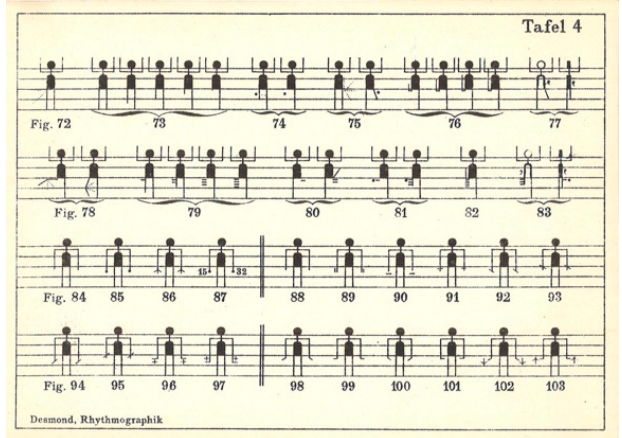
Figure 4. Excerpt from Olga Desmond, Rhythmographik (Tanznotenschrift) als Grundlage zum Selbststudium des Tanzes. Leipzig: Breitkopf & Härtel, 1919.